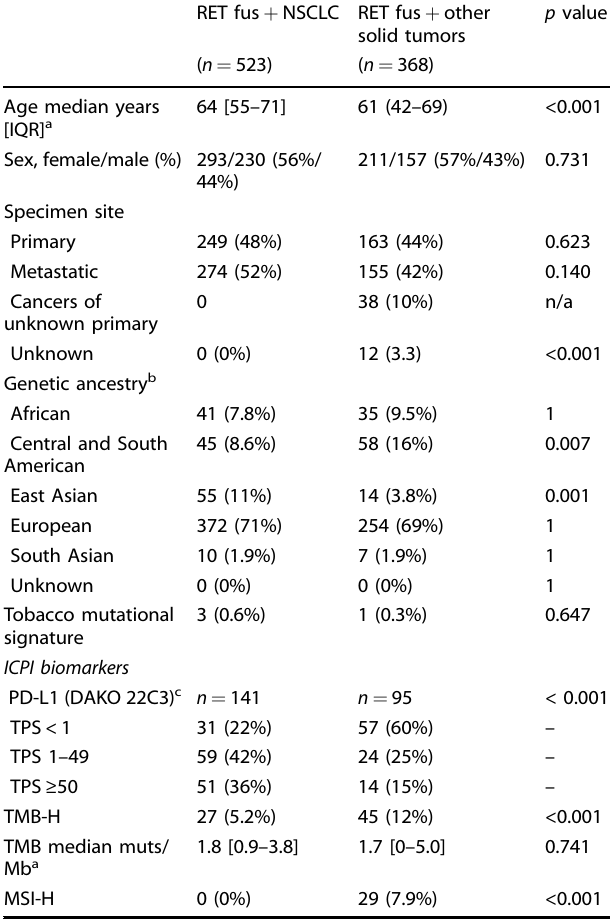
Table 1. Comparison of clinicopathologic and genomic biomarker